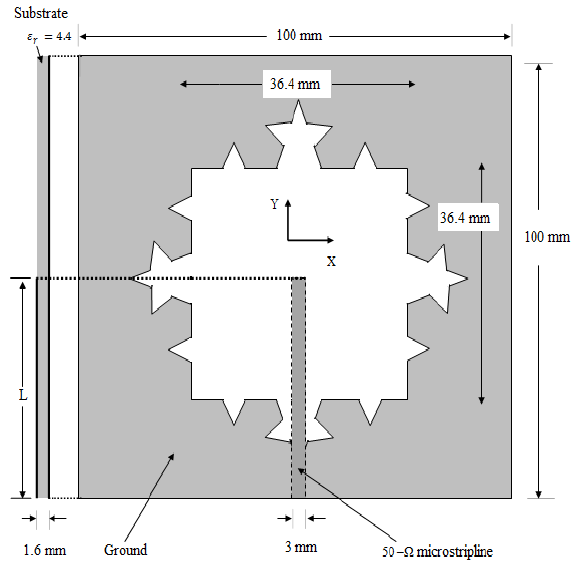
Figure 2. Geometry and dimensions of the proposed microstrip-line-fed printed Fractal-shaped slot antenna (IF=0.5, IO=2, IA=60 0 ).